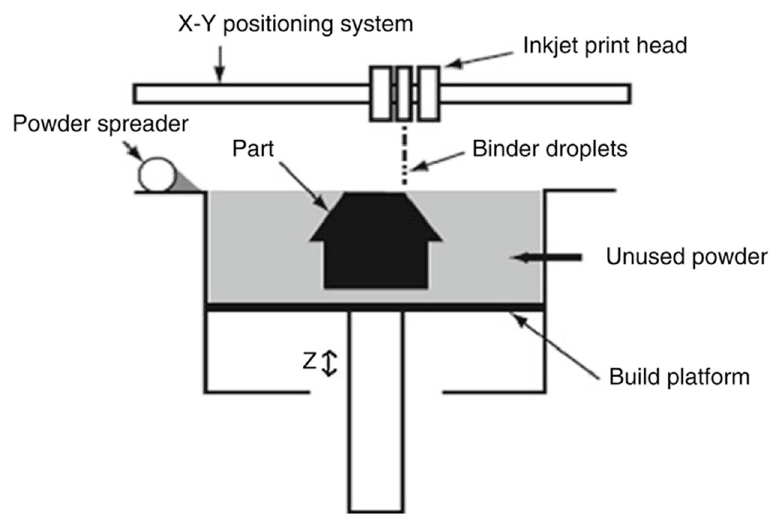
Figure 1. Schematic of binder jetting printing process [26] .